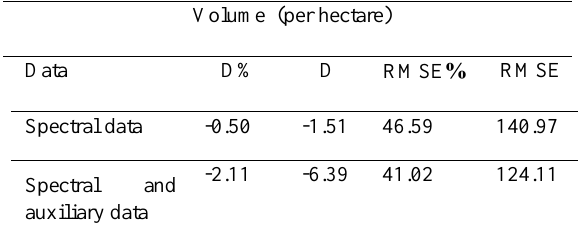
spectral and auxiliary data.